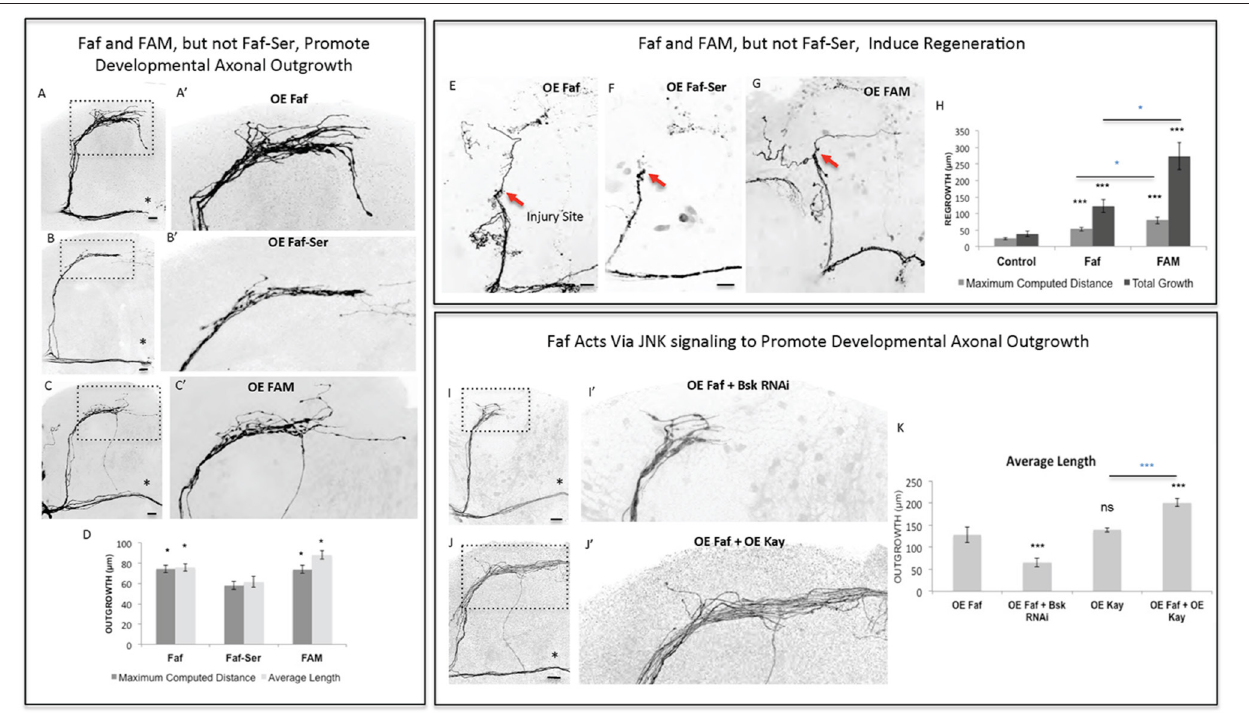
FIGURE 4 | Faf and FAM, but not Faf-Ser, promote axonal outgrowth in development and axonal regrowth after injury, and interact with the JNK signaling pathway. (A–C) Representative images of sLNv axonal arborization in adult flies where developmental overexpression of Fat facets , faf (A,A’) , Fat-Serine , Faf-Ser (B,B’) , and FAM (C,C’) has been specifically induced in the sLNvs. (D) Morphometric analysis (Maximum Computed Distance and Average Length) of sLNv axonal projections for (A–C). Axonal outgrowth is measured in µ m. (E–G) Representative images of sLNv axonal regrowth 4 days after injury in flies where overexpression of faf (E) , Faf-Ser (F), and FAM (G) has been specifically induced in the sLNvs. (H) Morphometric analysis (Maximum Computed Distance and Total growth) of regenerated sLNv axonal projections in (E–G). Axonal outgrowth is measured in µ m. (I,J) Representative images of sLNv axonal arborization for epistasis experiments between faf and Bsk (I,I’) and faf and kay (J,J’) . (K) Morphometric analysis (Average Length) of sLNv axonal projections where developmental overexpression of faf ; faf and Bsk RNAi; kay ; and faf and kay , has been specifically induced in the sLNvs. Axonal outgrowth is measured in µ m. Genotype of flies in (A,A’,E) is PDF-Gal4, UAS-GFP/ + ; PDF-Gal4, UAS-2x eGFP/ + ; UAS-Faf/ + , in (B,B’,F) is PDF-Gal4, UAS-GFP/ + ; PDF-Gal4, UAS-2x eGFP/ + ; UAS-Faf-Ser/ + , in (C,C’,G) is PDF-Gal4, UAS-GFP/ + ; PDF-Gal4, UAS-2x eGFP/ + ; UAS-FAM/ + , in (I,I’) is PDF-Gal4, UAS-GFP/ + ; PDF-Gal4, UAS-2x eGFP/ + ; UAS-Faf/UAS-Bsk RNAi, in (J,J’) is PDF-Gal4, UAS-GFP/ + ; PDF-Gal4, UAS-2x eGFP/ + ; EP-Faf/UAS-kay. Dotted insets have been zoomed in to better illustrate the diverse axonal phenotypes obtained. Asterisk denotes the brain midline, red arrow denotes the injury point. * p < 0.05; *** p < 0.001. n.s. indicates no statistical significance. Error bars represent SEM. Dotted insets have been zoomed in to better illustrate the diverse axonal phenotypes obtained. OE indicates overexpression. Scale bars are 20 µ